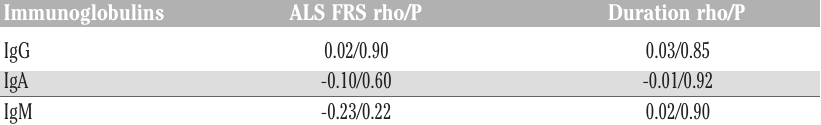
Table 2. Correlations of immunoglobulin levels of amyotrophic lateral sclerosis patients with clinical parameters.